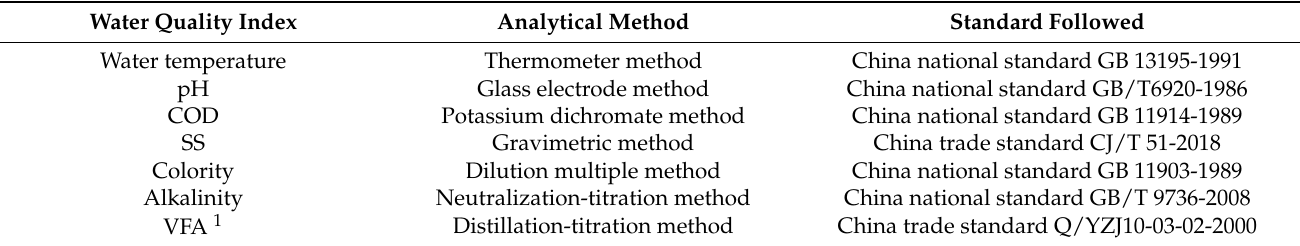
Table 2. Analytical methods for the investigated water quality